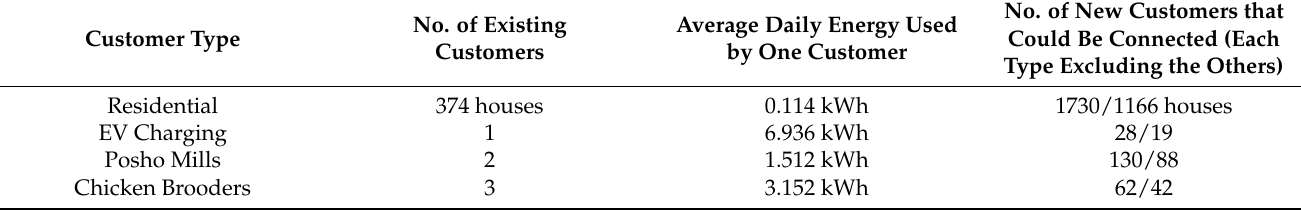
Table 8. Maximum number of new residential and PUE customers using annual average daily demand (the first value in the last column is for ERF pv = 1, while the second value is for ERF pv =